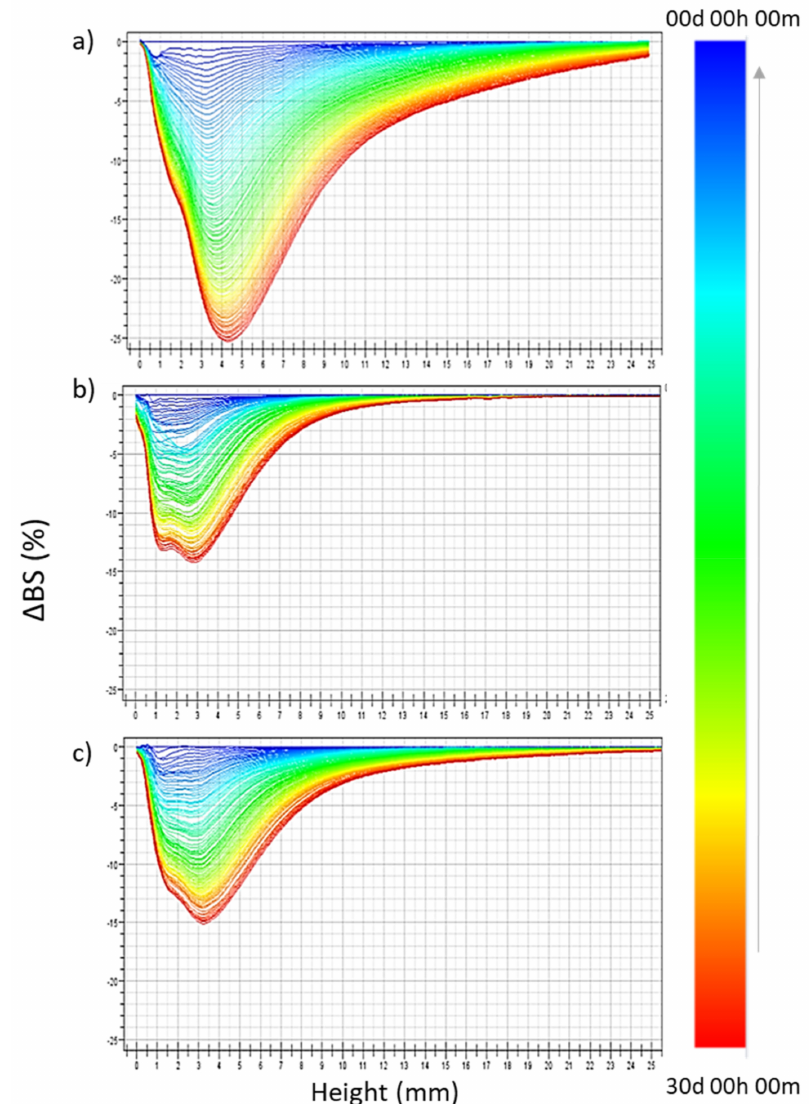
Figure 2. Backscattering profiles ( ∆ BS) of CT-NLC ( a ), L-NLC ( b ), and N-NLC ( c ) stored in Turbiscan ® for 30 days at a temperature of 25.0 ± 1.0 ◦ C. Data are presented as a function of time (0–30 days) of sample height (0 to 20 mm) (the direction of analysis time is indicated by the